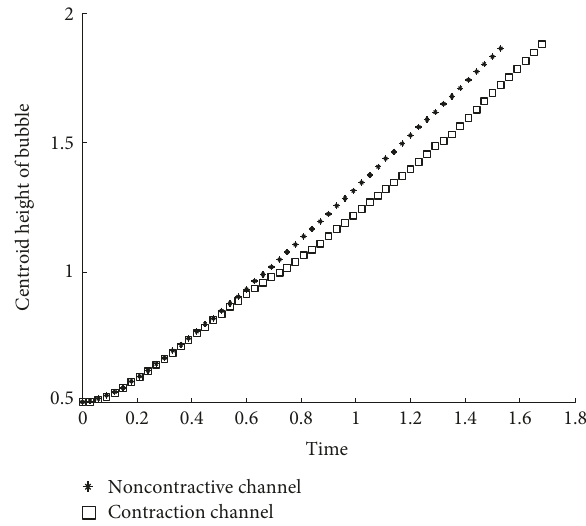
Top of the bubble and contraction channel Bottom of the bubble and contraction channel Top of the bubble and noncontractive channel Bottom of the bubble and noncontractive channel Figure 7: The velocity of the bubbles in the contractive and noncontractive channels (Re =70, Mo=8 × 10 − 5 , and Eo=3.2).